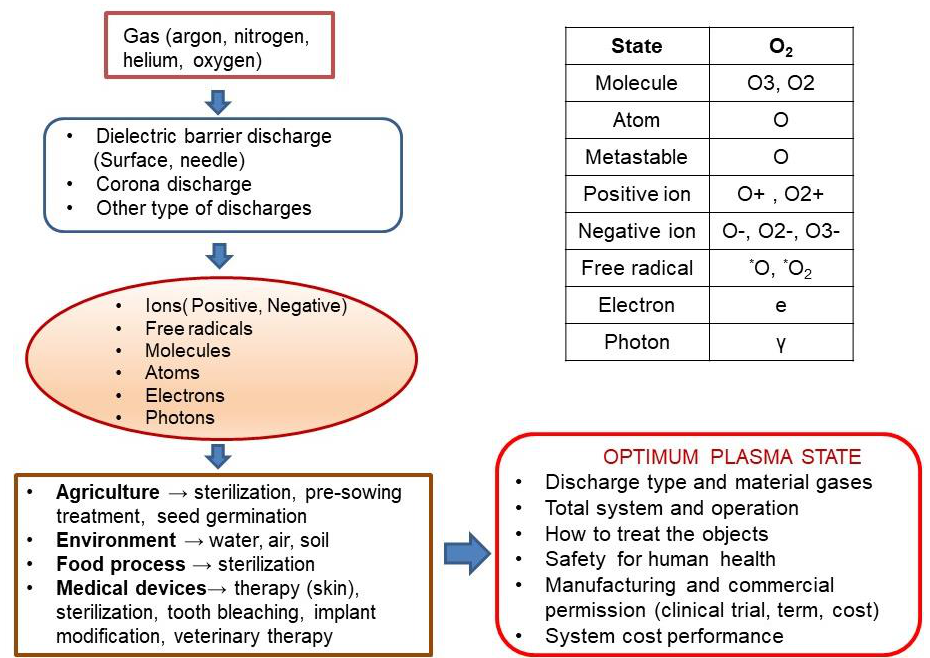
Figure 1. The technological complexity of plasma applications in agriculture and biomedicine.